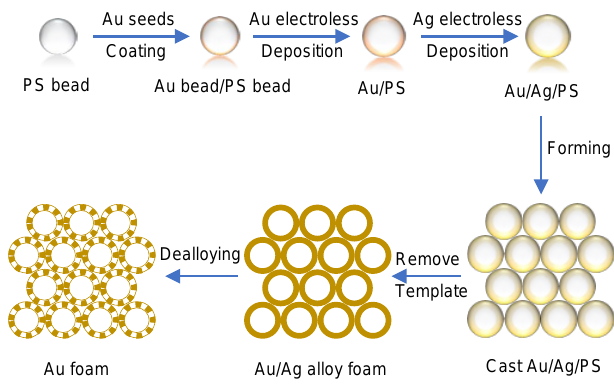
Figure 1. A scheme of the template-dealloying process for synthesizing Au foam.